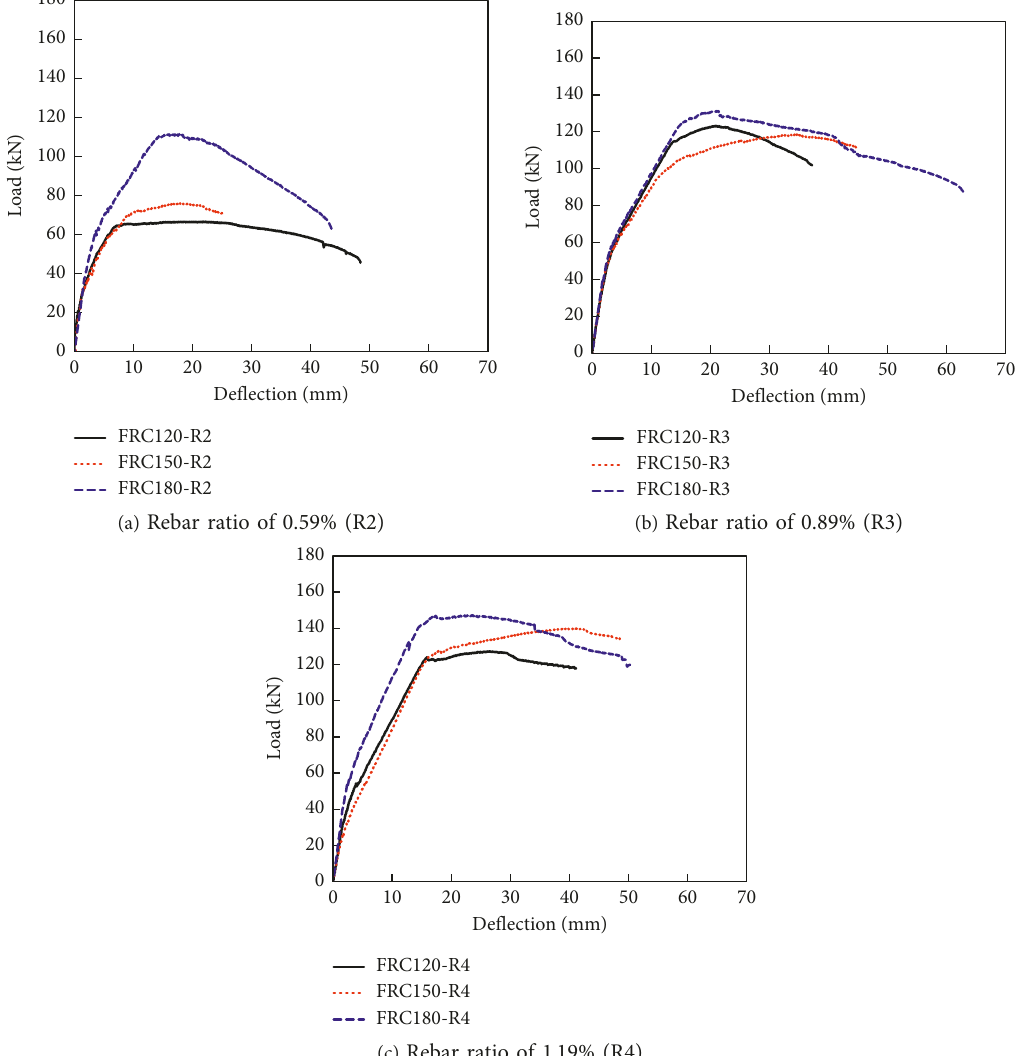
Figure 9: Load-deflection relationship